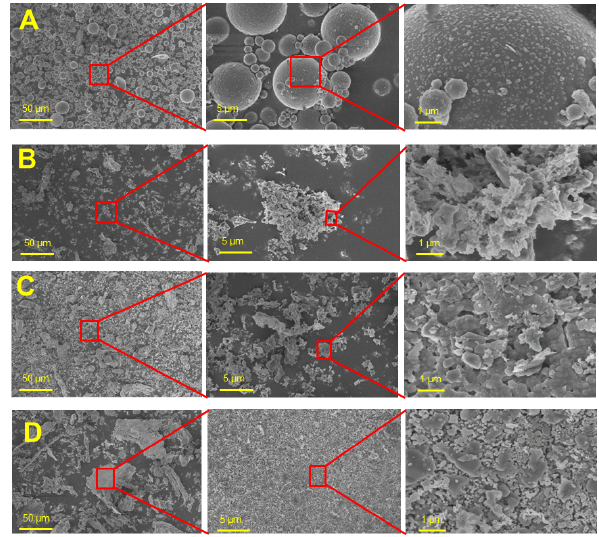
Figure 2. Scanning electron microscopy (SEM) images of CFA (a) , wood bottom ash (b) , domestic bottom ash (c) , and coal bottom ash (d) that were used for this ice nucleation study. All ash particles were sieved to ≤ 40µm before the SEM images were taken. From left to right, the red boxes and their handles show different magni- fications as presented with the scales on each SEM image